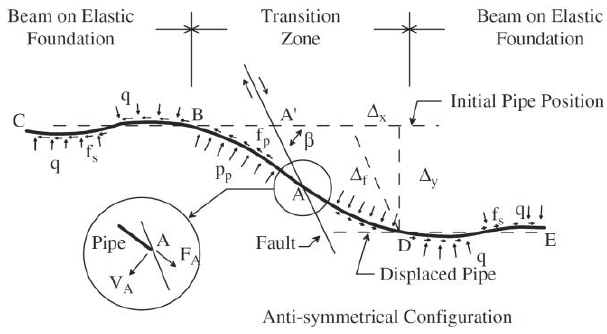
Figure 1. Pipeline analysis model proposed by Wang and Yeh